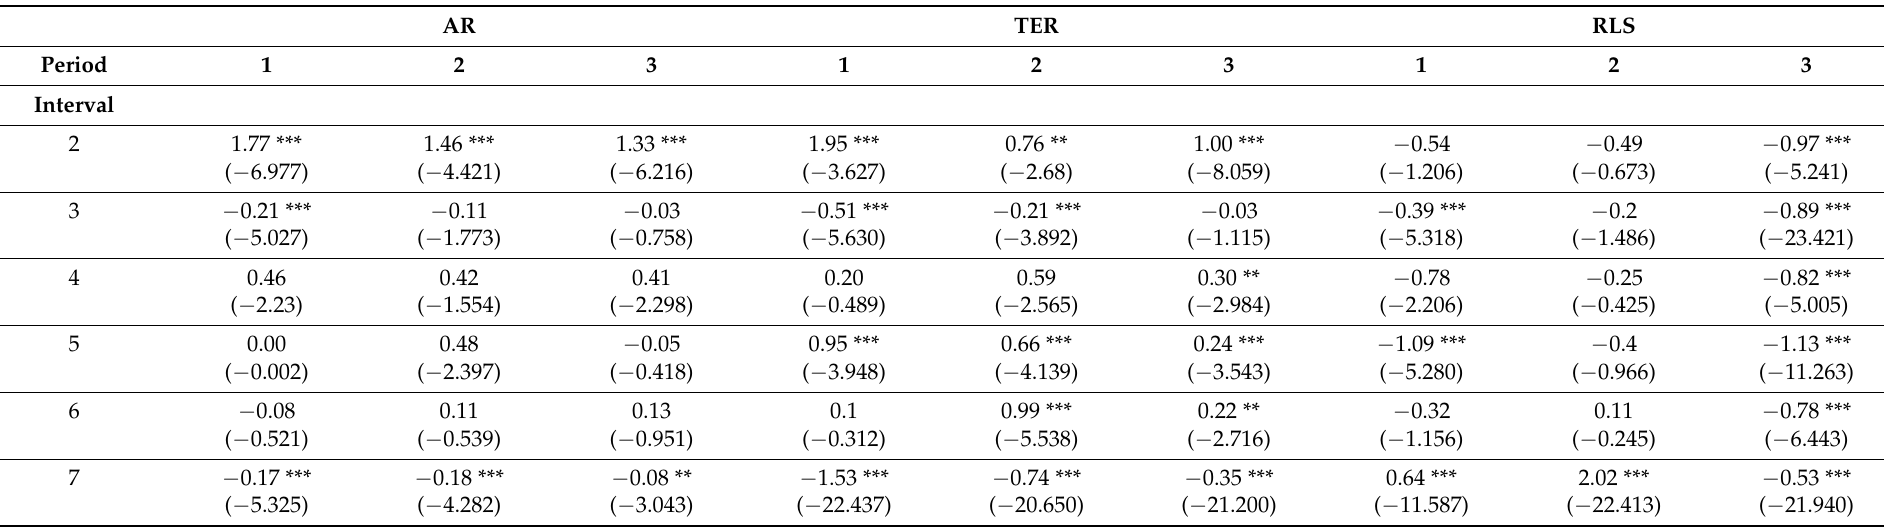
Table 1. Abnormal returns (%) and liquidity measurements (%) in three sub-periods of study. AR TER RLS